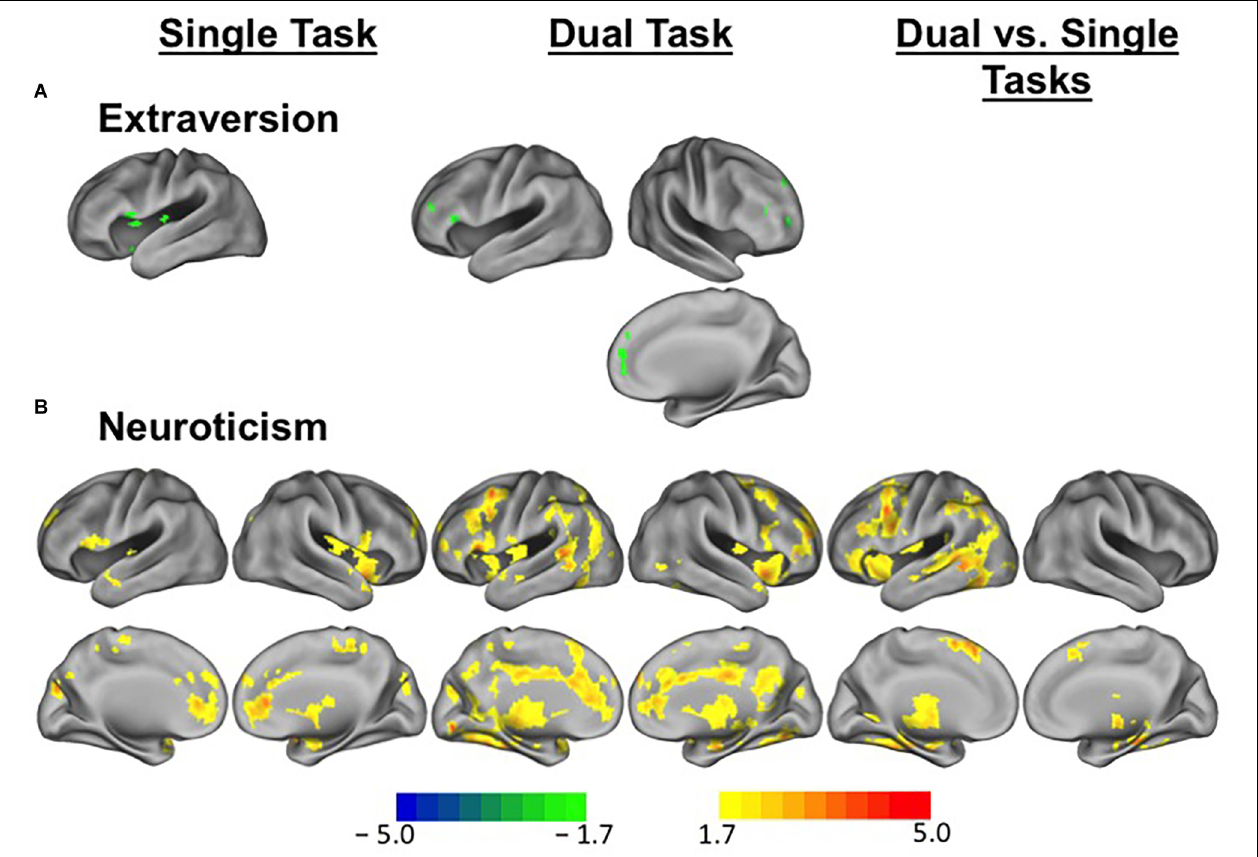
FIGURE 2 | Differential brain activity patterns in association with extraversion and neuroticism among young adults. (A) Task-evoked brain activity during executive control tasks in relation to extraversion scores among young adults. Regions in green indicate suprathreshold voxels showing lower brain activity in relation to higher extraversion scores for single task vs. baseline and dual-task vs. baseline comparisons. (B) Task-evoked brain activity during executive control tasks in relation to neuroticism scores among young adults. Regions in warm colors indicate suprathreshold voxels showing increased brain activity in relation to higher neuroticism scores for single task vs. baseline and dual-task vs. baseline comparisons and dual vs. single task contrasts. Scale represents T